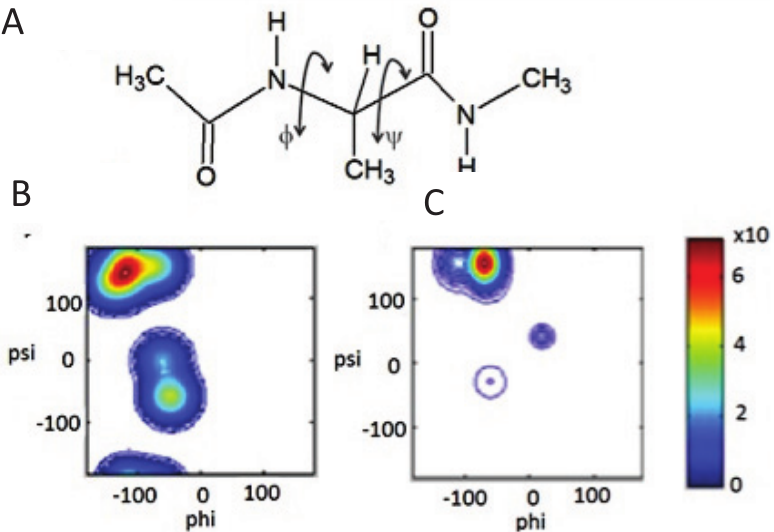
Figure 2. ( A ) The chemical structure of the alanine dipeptide with backbone (cid:4),(cid:5) angles noted; ( B ) The Ramachandran plot depicted the local random coil distribution of the alanine residue of the alanine dipeptide; ( C ) The experimentally obtained Ramachandran plot of the alanine residue of the alanine dipeptide in water as reported by Toal et al. [15] . (Taken from ref. [15] and